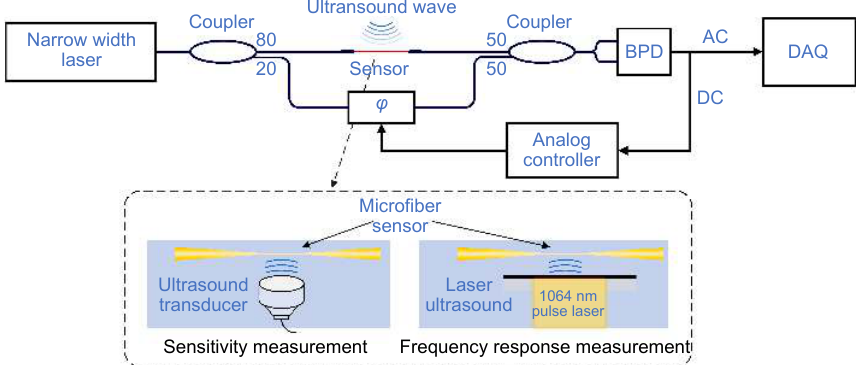
Fig. 2 | The diagram of ultrasound detection system. φ : Phase modulator. BPD: Balanced photodetector. DC: Direct current signal. AC: Al- ternating current signal. DAQ: Data acquisition card.